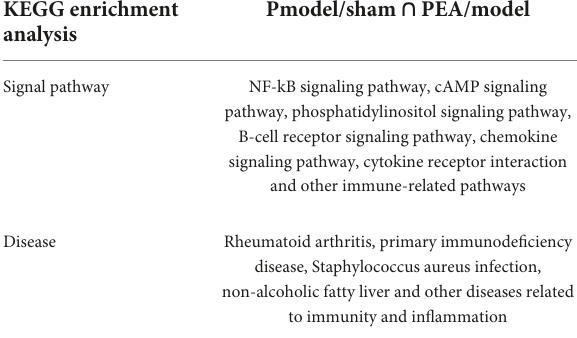
TABLE 3 Similar KEGG enrichment results between Pmodel/sham and PEA/model. KEGG enrichment